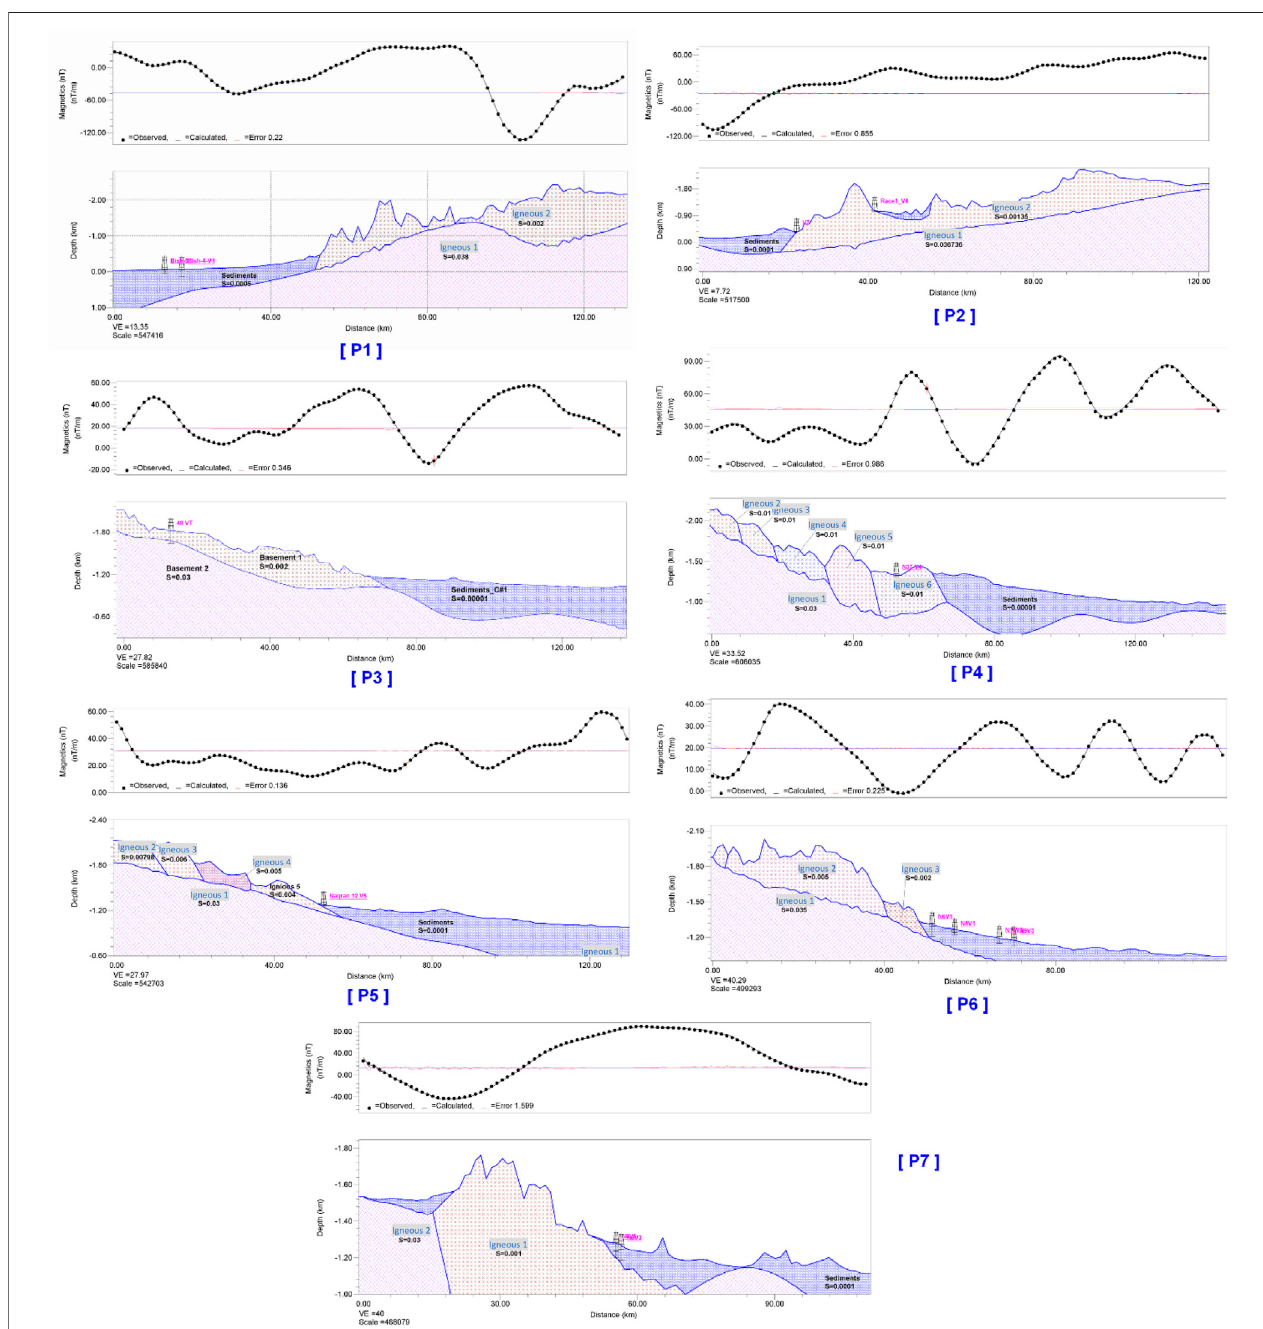
FIGURE 11 | The 2D inverted magnetic